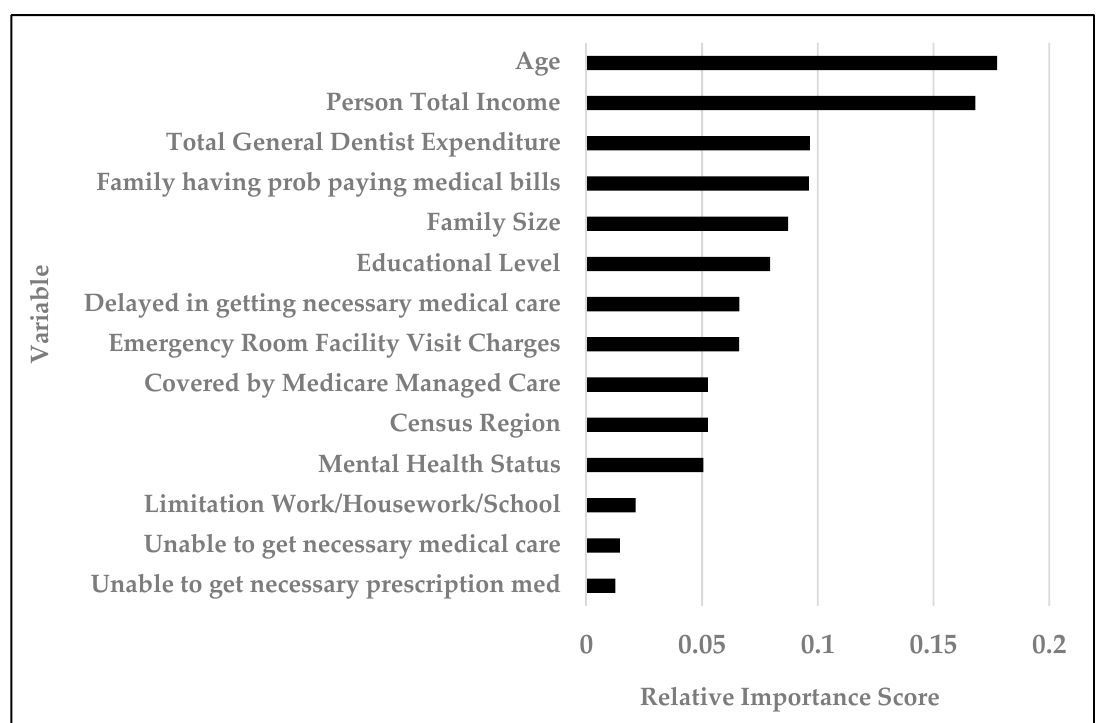
Figure 1. Relative importance of variables in predicting unmet dental care needs.